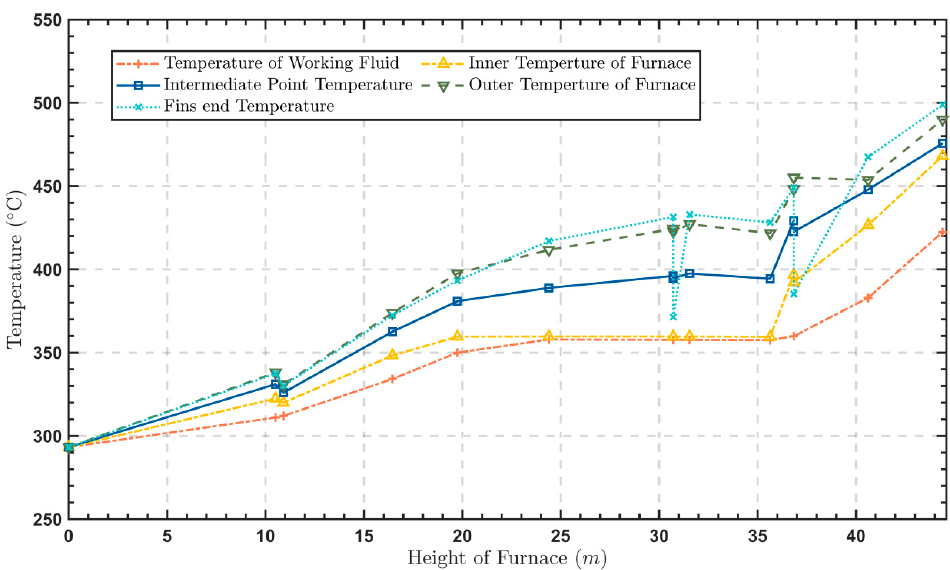
Figure 15. Wall temperature distribution of 15th circuit in furnace.